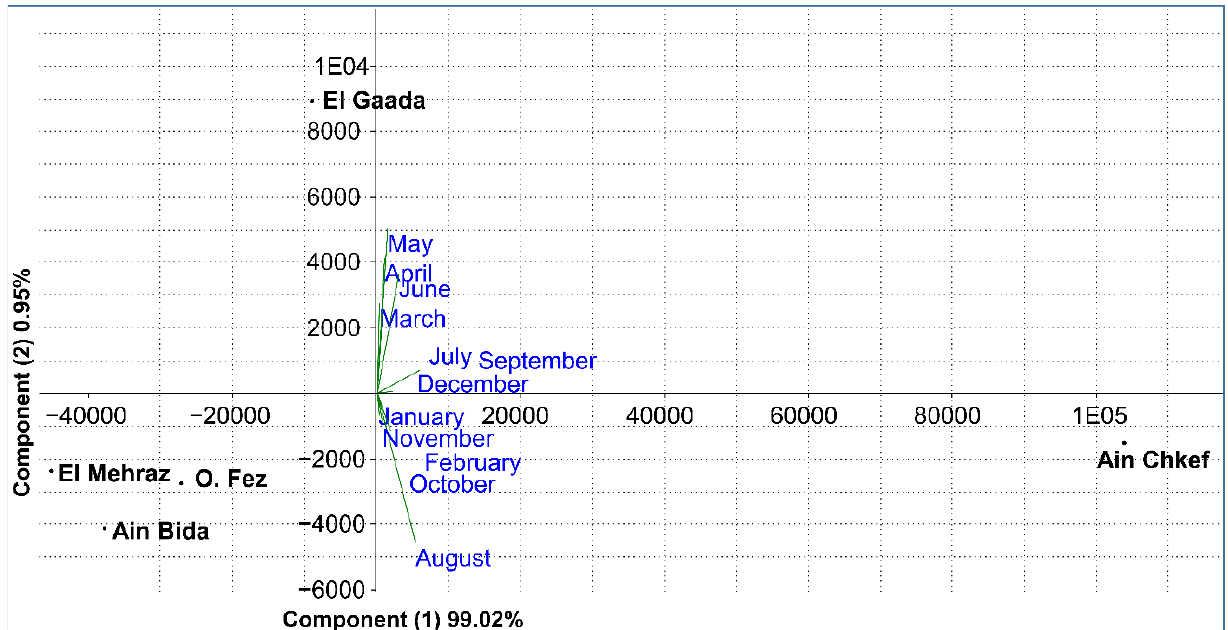
Figure 6. Periods of tourists visiting studied sites between 2018 and 2019.